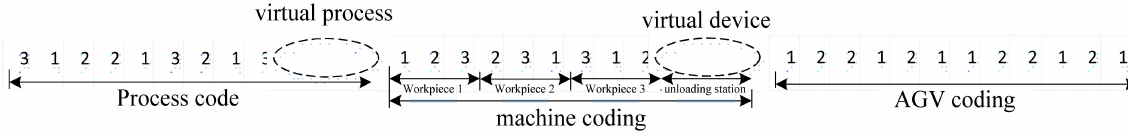
Figure 1. Individual coding gene